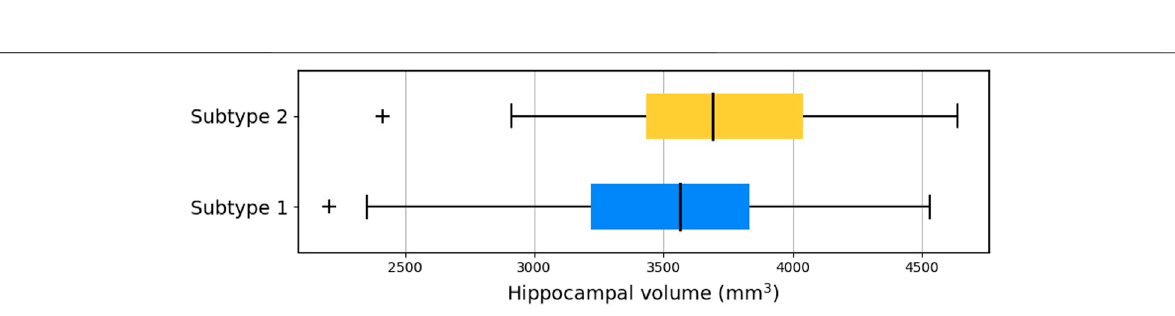
Frontiers in Big Data |